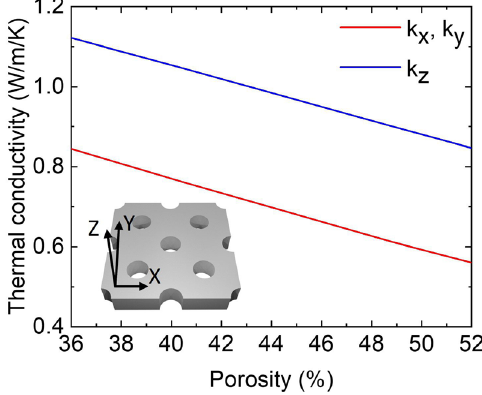
Figure 3: Effective thermal conductivity of AAO with different porosities simulated using the finite element method. Inset: AAO hexagonal lattice